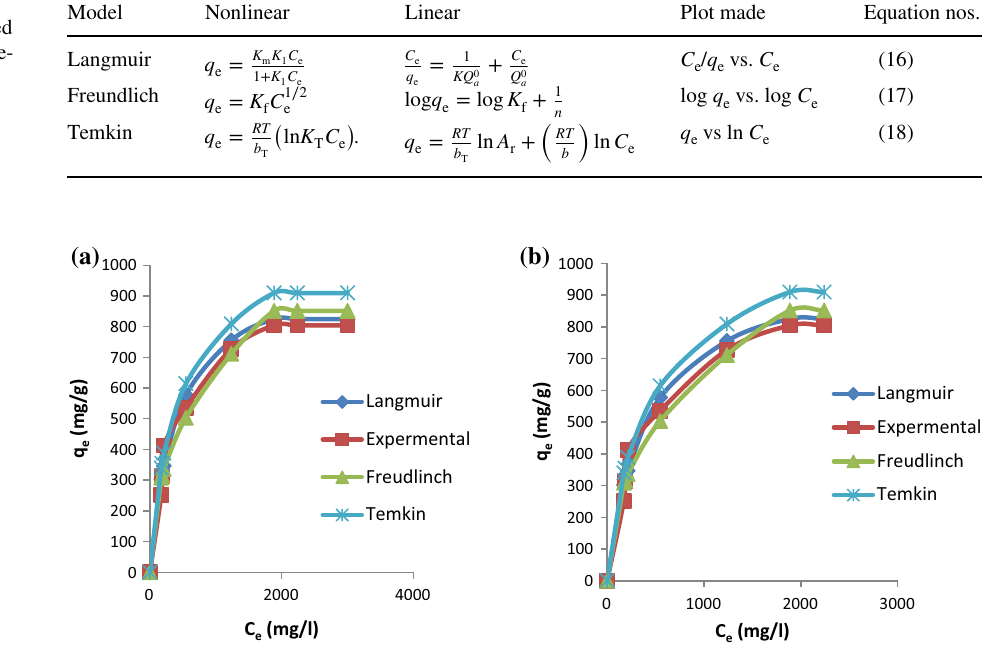
Table 5 Linear and nonlinear isotherm model equations used for the analyses of coagulative-